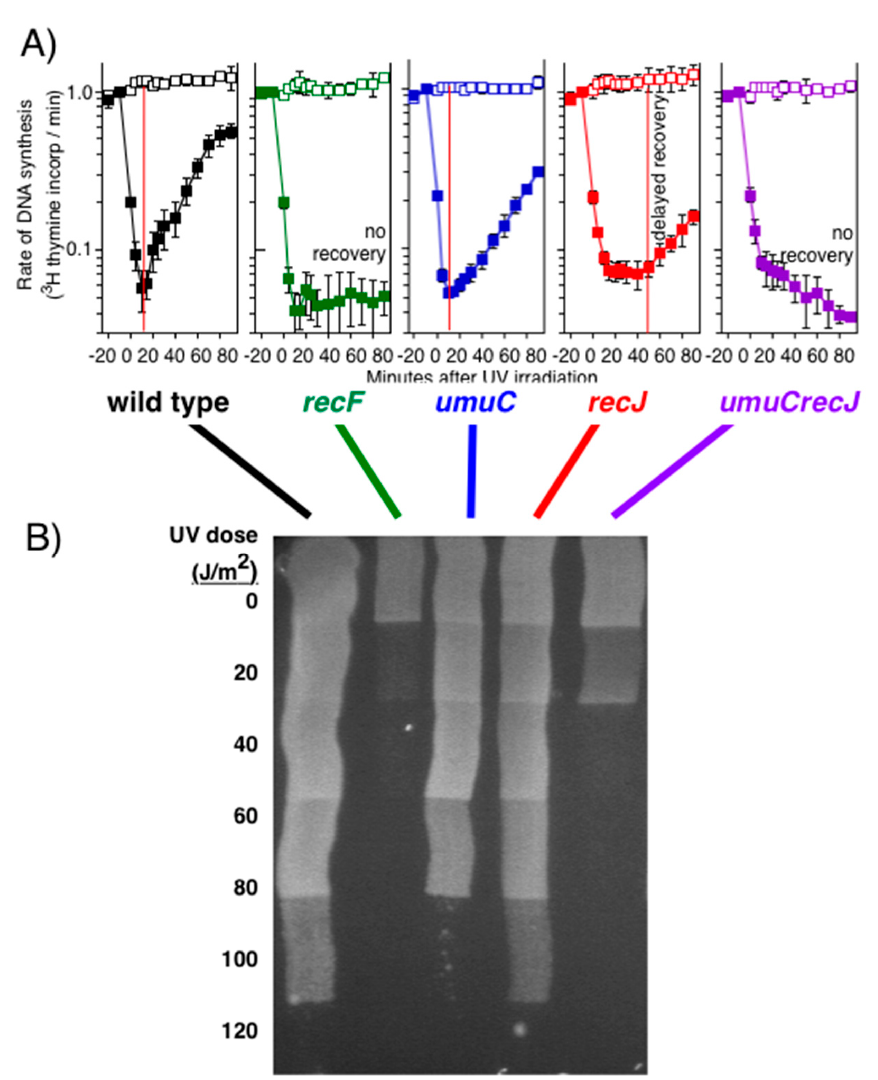
Figure 7. In the absence of RecJ processing, repair cannot occur and replication recovery and cell survival become dependent on translesion synthesis. ( A ) In the absence of RecJ, the recovery of replication is delayed and becomes entirely dependent on translesion synthesis by PolV, encoded by umuC . To measure the time at which replication resumes, [ 3 H]thymidine was added to cultures for 2 min at the indicated times following either 27 J/m 2 UV irradiation (filled symbols) or mock irradiation (open symbols) at time 0. The relative amount of DNA synthesis/2 min, 3 H (squares), is plotted. The time replication resumes is indicated by the red line on each graph. ( B ) In the absence of RecJ, survival becomes dependent on translesion synthesis by Pol V . The relative survival of each culture following UV irradiation with the indicated dose is shown. A fresh overnight culture was evenly applied onto a Luria-Bertani medium plate with a cotton swab. The plate was covered, placed under a UV lamp, and the cover was progressively retracted following 20 J/m 2 exposures. Redrawn from data reported in [55,56].